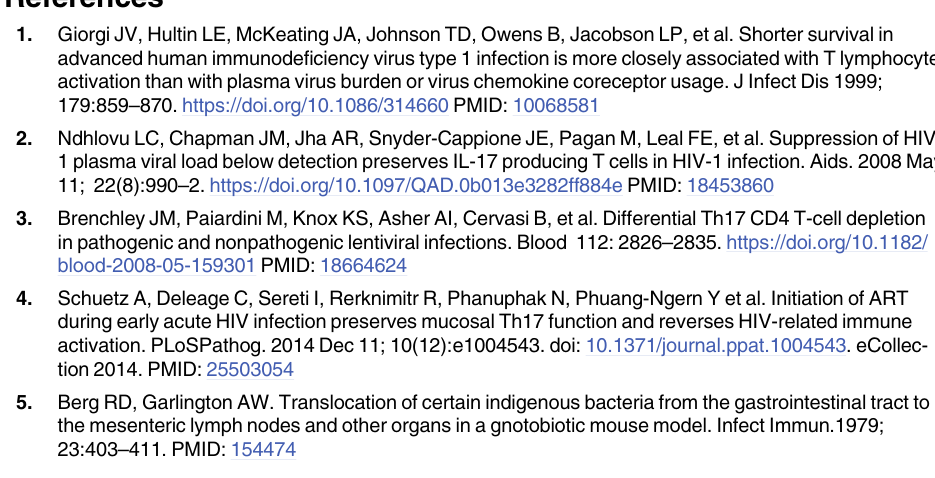
S2 Table. Presentation of patients characteristics. Characteristics (age, CD4+T cell count, CD4+ nadir, antiviral regimens, duration of therapy, plasma HIV-1 RNA level, year of diagno- sis) of patients from the Liege AIDS reference center (N = 75) are presented. “NT” indicates “Not Treated”. “NA” indicates “Not